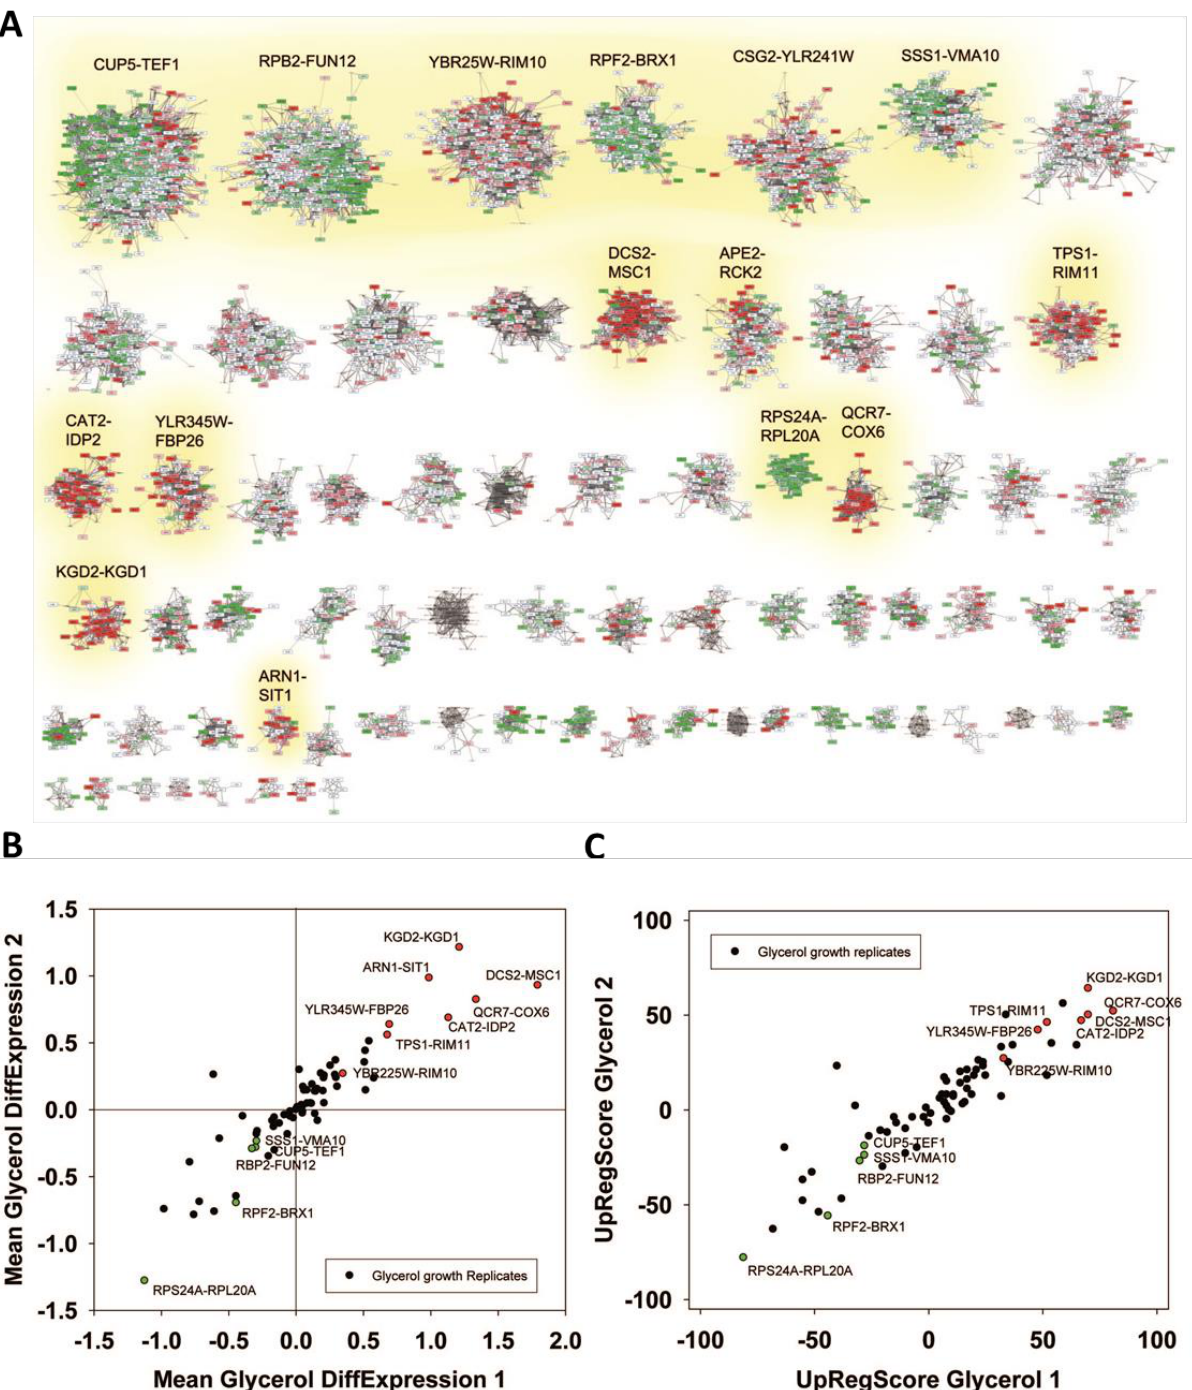
FIGURE 3. Analysis of microarray data sets on growth conditions. ( A ) Differences between glycerol-induced growth and glucose supported growth as described by [38]. Downregulation is indicated by four levels of green, upregulation by four levels of red. Significantly changed cliques of replicate 1 are highlighted with yellow background and labelled. ( B ) Correlation between two replicates and indication as to which values show significant upregulation in both replicates (red dots). The same is applied for downregulation (green labelling). ( C ) Comparison between two replicates regarding the UpRegScore of each clique. The labelling is performed as in Figure